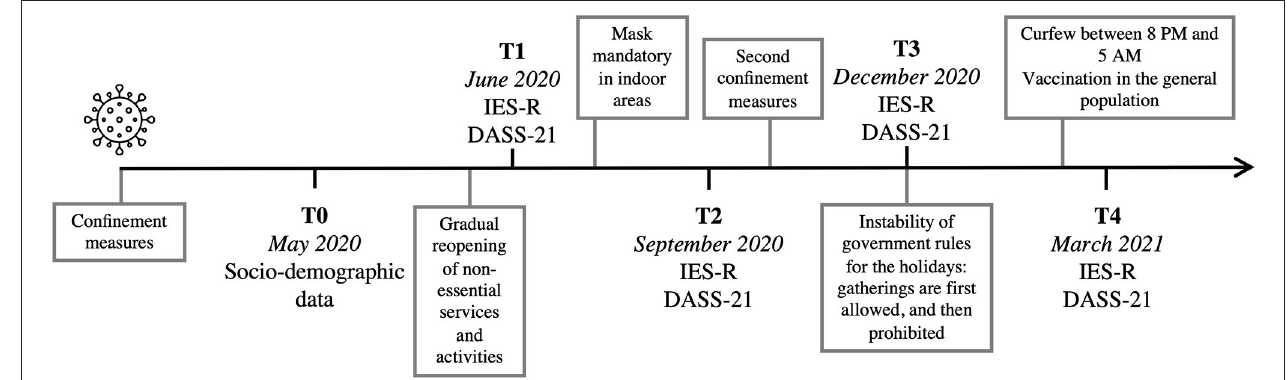
FIGURE 1 | Timeline overview.